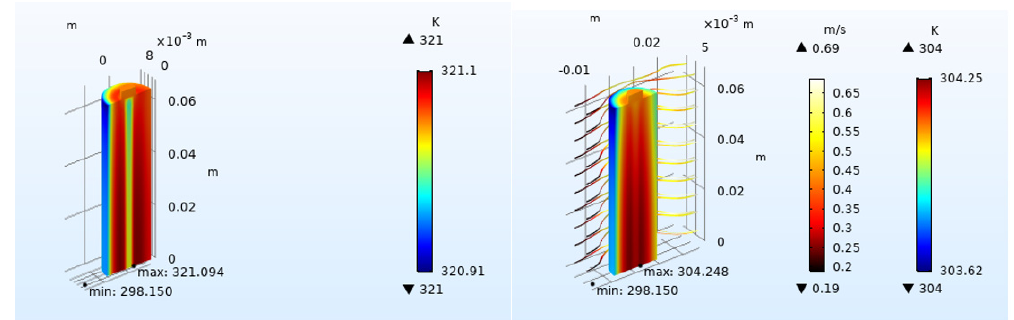
Figure 11. Comparison of heat dissipation effect with airflow field.